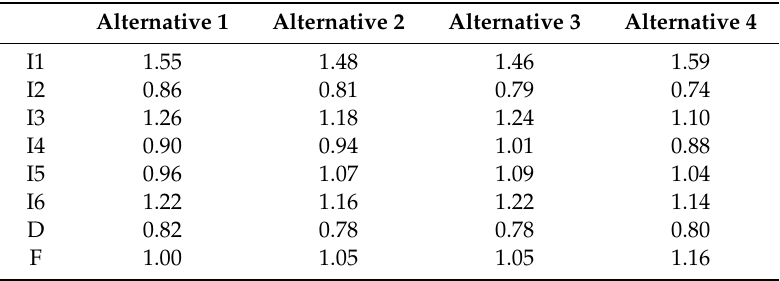
Table A12. Weighted decision